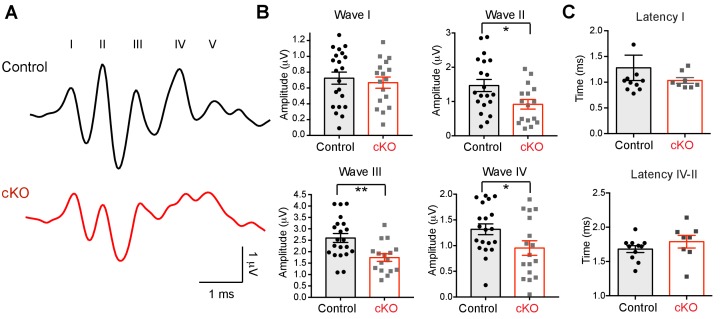
The absence of oligodendroglial BDNF impairs the auditory function of Bdnf cKO mice.(A) Examples of the ABRs in a control (black) and a Bdnf cKO mouse (red, both at P25), were recorded in response to a click stimulus of sound (75 dB). Roman numerals indicate peak waves I to V. (B) Summary of the amplitude of waves I to IV in response to click stimulus (75 dB), and the latency of wave I and the latency between wave II and IV in control (black) and Bdnf cKO mice (red). Data are shown as the mean ± s.e.m. *p<0.05; **p<0.01 (unpaired t-test).